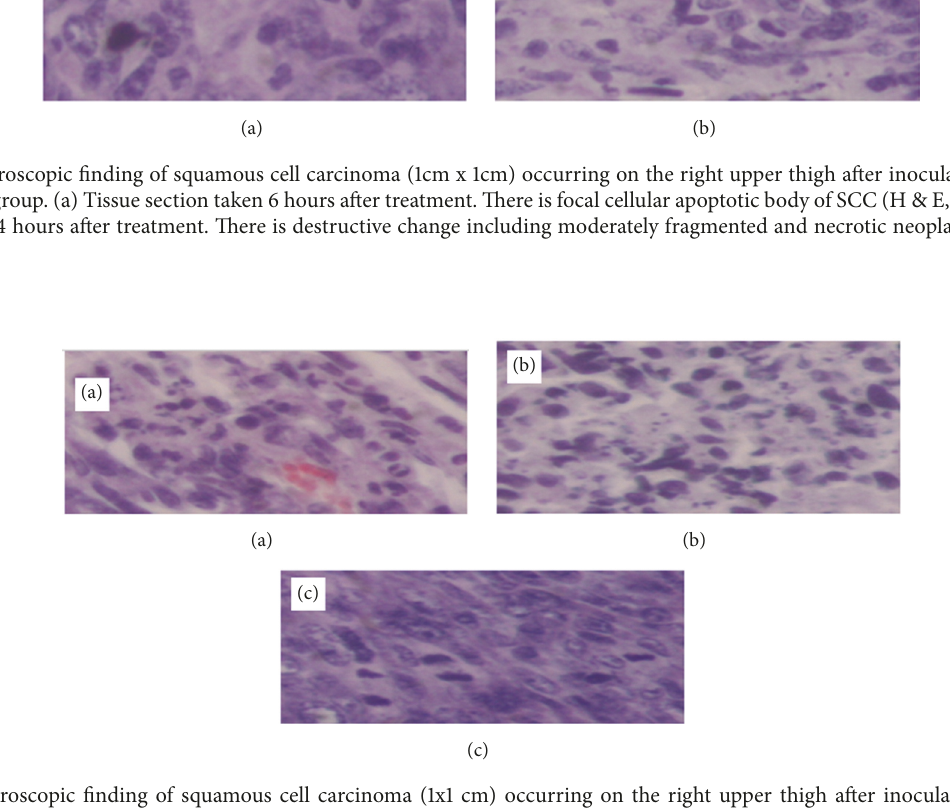
Figure 17: Microscopic finding of squamous cell carcinoma (1x1 cm) occurring on the right upper thigh after inoculation of SCC-7 in 10mA × 600sec group. (a) Tissue section taken 6 hours after treatment. There are many pyknosis neoplastic cells and also some typical spindle cells with mitosis (H & E, x400). (b) Tissue section taken 12 hours after treatment. There are many destructive neoplastic cells (H & E, x400). (c) Tissue section taken 24 hours after treatment. There are diffuse, numerous cellular debris derived from neoplastic cells (H & E,